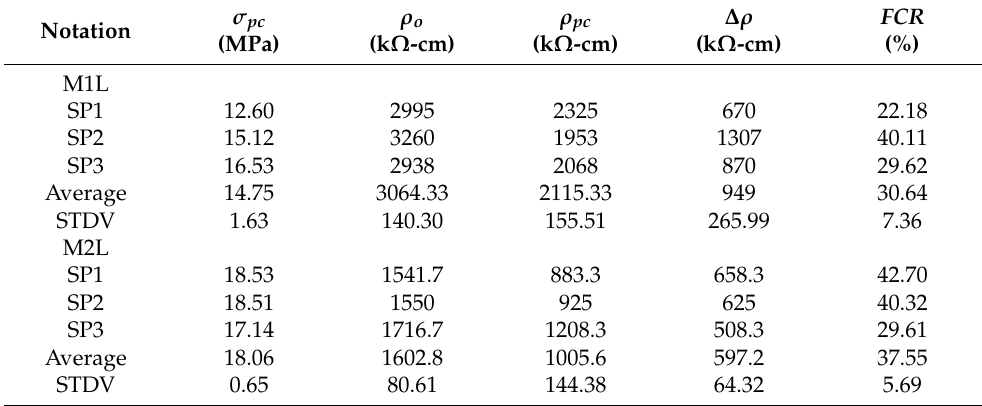
Figure 18. Electrical resistivity response of S-UHPCs using WSS with multiple channel measurements under tension. Table 6. Tensile resistivity test results of Part A in double-edged notch specimens.